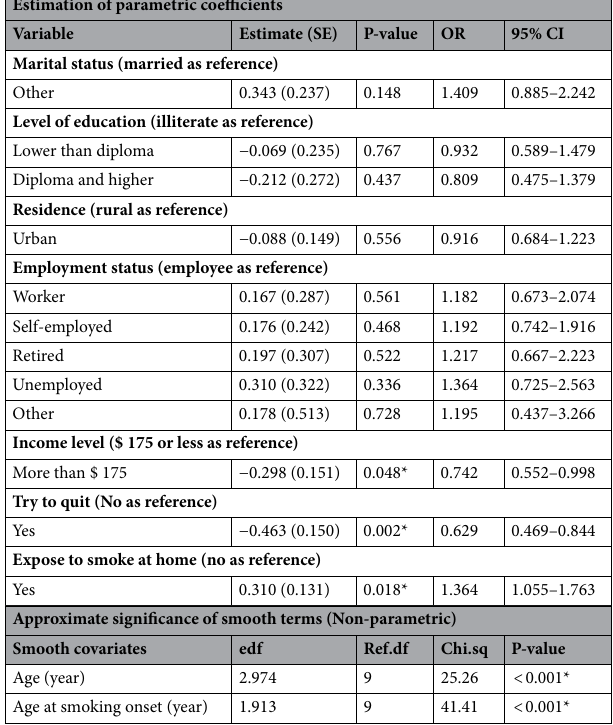
Table 2. Association of intensity of cigarette smoking (heavy vs light and moderate smokers) and independent variables measured by the generalized additive model. *Significant at 0.05.